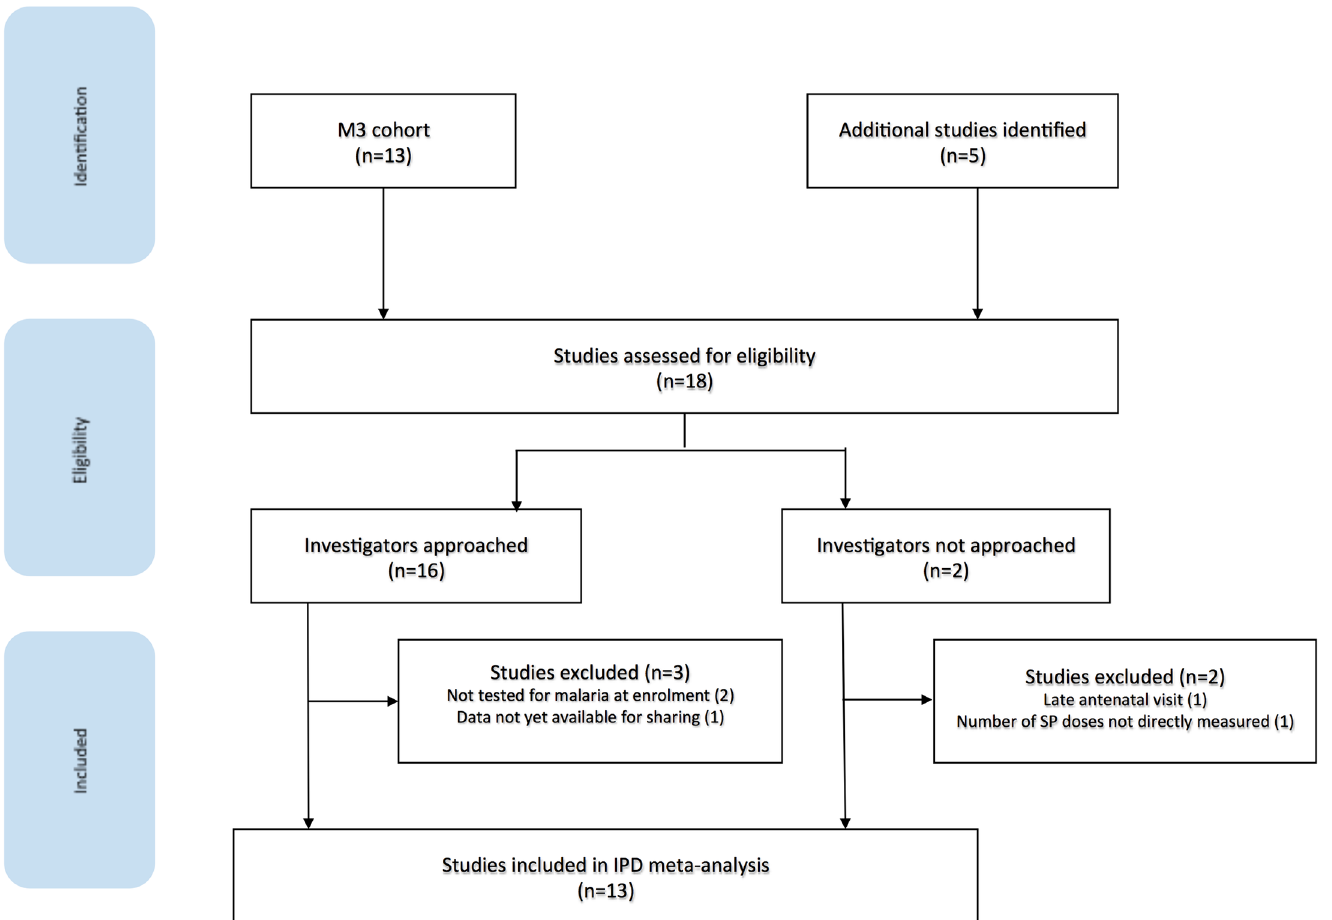
Fig 1. Flow diagram of studies included in the individual participant meta-analysis of the interaction between malaria infection and maternal malnutrition on birthweight. M3, Maternal Malaria and Malnutrition Initiative.